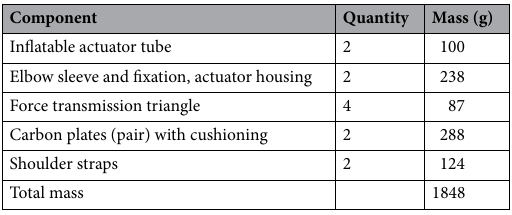
Table 1. System components worn by the